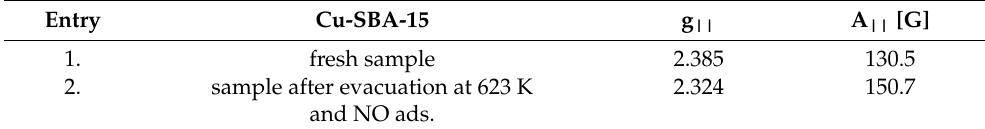
Table 2. Parameters of EPR spectra (g factors and hyperfine splittings A